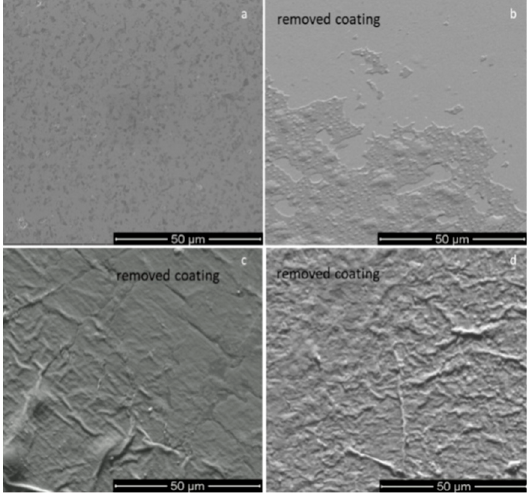
Figure 10. Tape tests for calcium phosphate coatings deposited on Ti substrates at ( a ) p = 1.2 × 10 − 2 mbarr; ( b ) p = 4.6 × 10 − 3 mbarr; and on polyprophylene substrates at: ( c ) p = 1.2 × 10 − 2 mbarr; ( d ) p = 4.6 × 10 − 3 mbarr.